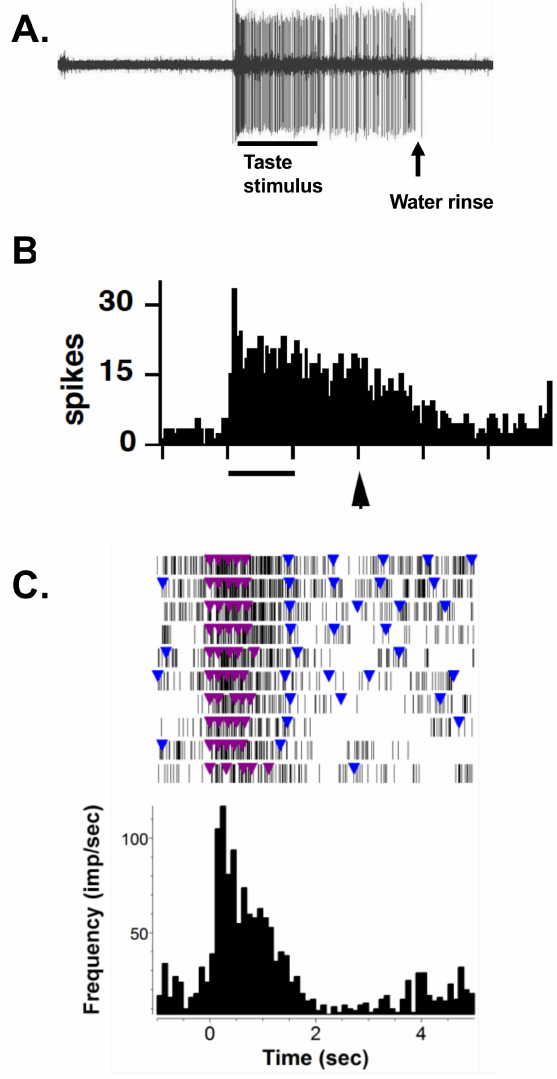
Figure 1. Examples of taste responses recorded from the nucleus of the solitary tract (NTS) in an anesthetized ( A ) and ( B ) and an awake, freely licking rat ( C ). ( A ) Firing pattern of a single NTS cell during the presentation of a taste stimulus for 5 s followed, after 5 s, by a water rinse in a urethane-anesthetized rat. ( B ) Peristimulus–time histogram (PSTH) showing the response during the presentation of a taste stimulus for 5 s (line under histogram) followed after 5 s by the presentation of a water rise for 20 s (arrow under histogram) in a urethane-anesthetized rat. ( C ) Raster (top) and PSTH (bottom) showing a taste response in an awake, freely licking rat. Colored triangles indicate licks: blue triangles show water licks; purple triangles show taste stimulus licks. Unreinforced licks between water licks are not shown. The taste stimulus trial consists of 5 consecutive stimulus licks. Ten trials are